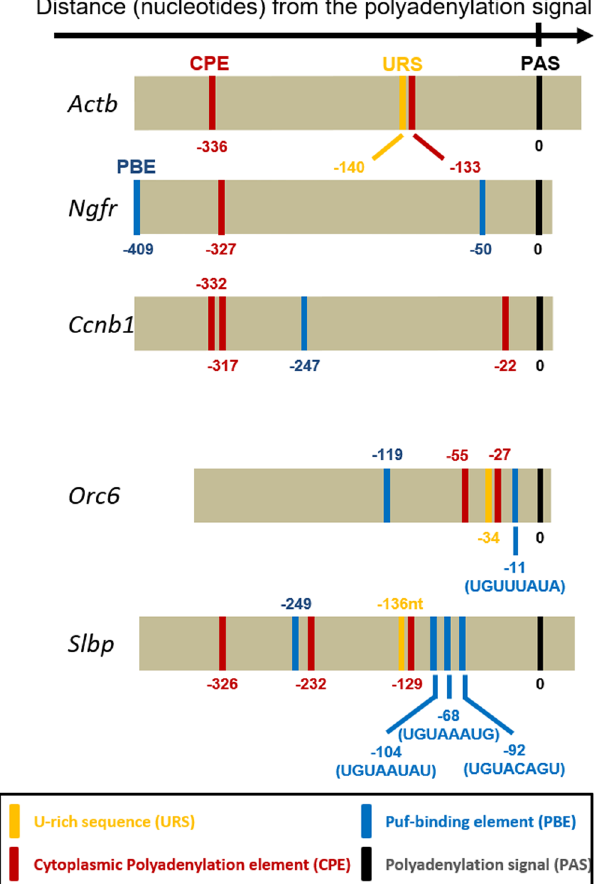
Figure 6. Terminal portion of the 3 ′ -UTR of different mRNAs showing location of sequences that potentially regulate polyadenylation. Locations are indicated relative to the polyadenylation signal (PAS, black bar; sequence: AUUAAA). Orc6 and Slbp mRNAs contain one or more potential PBE sequences (blue bars) located between the CPE (red bar) lying closest to the PAS and the PAS itself, whereas Actb , Ngfr and Ccnb1 do